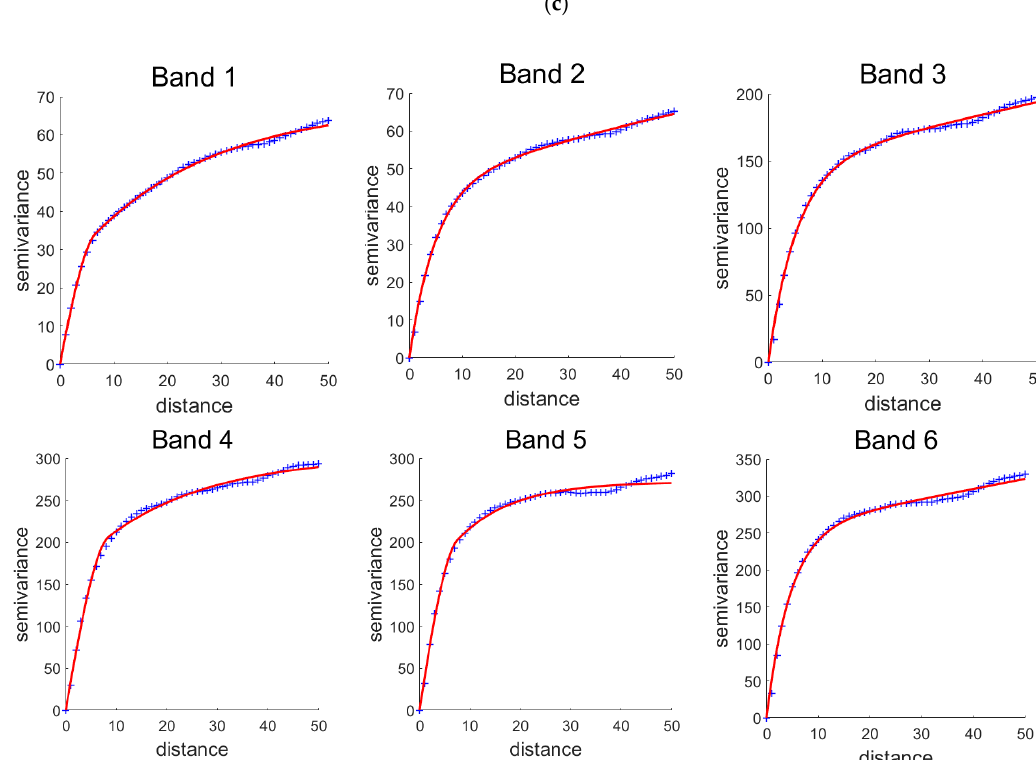
∼ Z (cid:48)(cid:48) ), ( b ) ICA-transformed ~ Z 6 1 1 ∼ Z (cid:48) ), and ( d ) original image bands 6 1